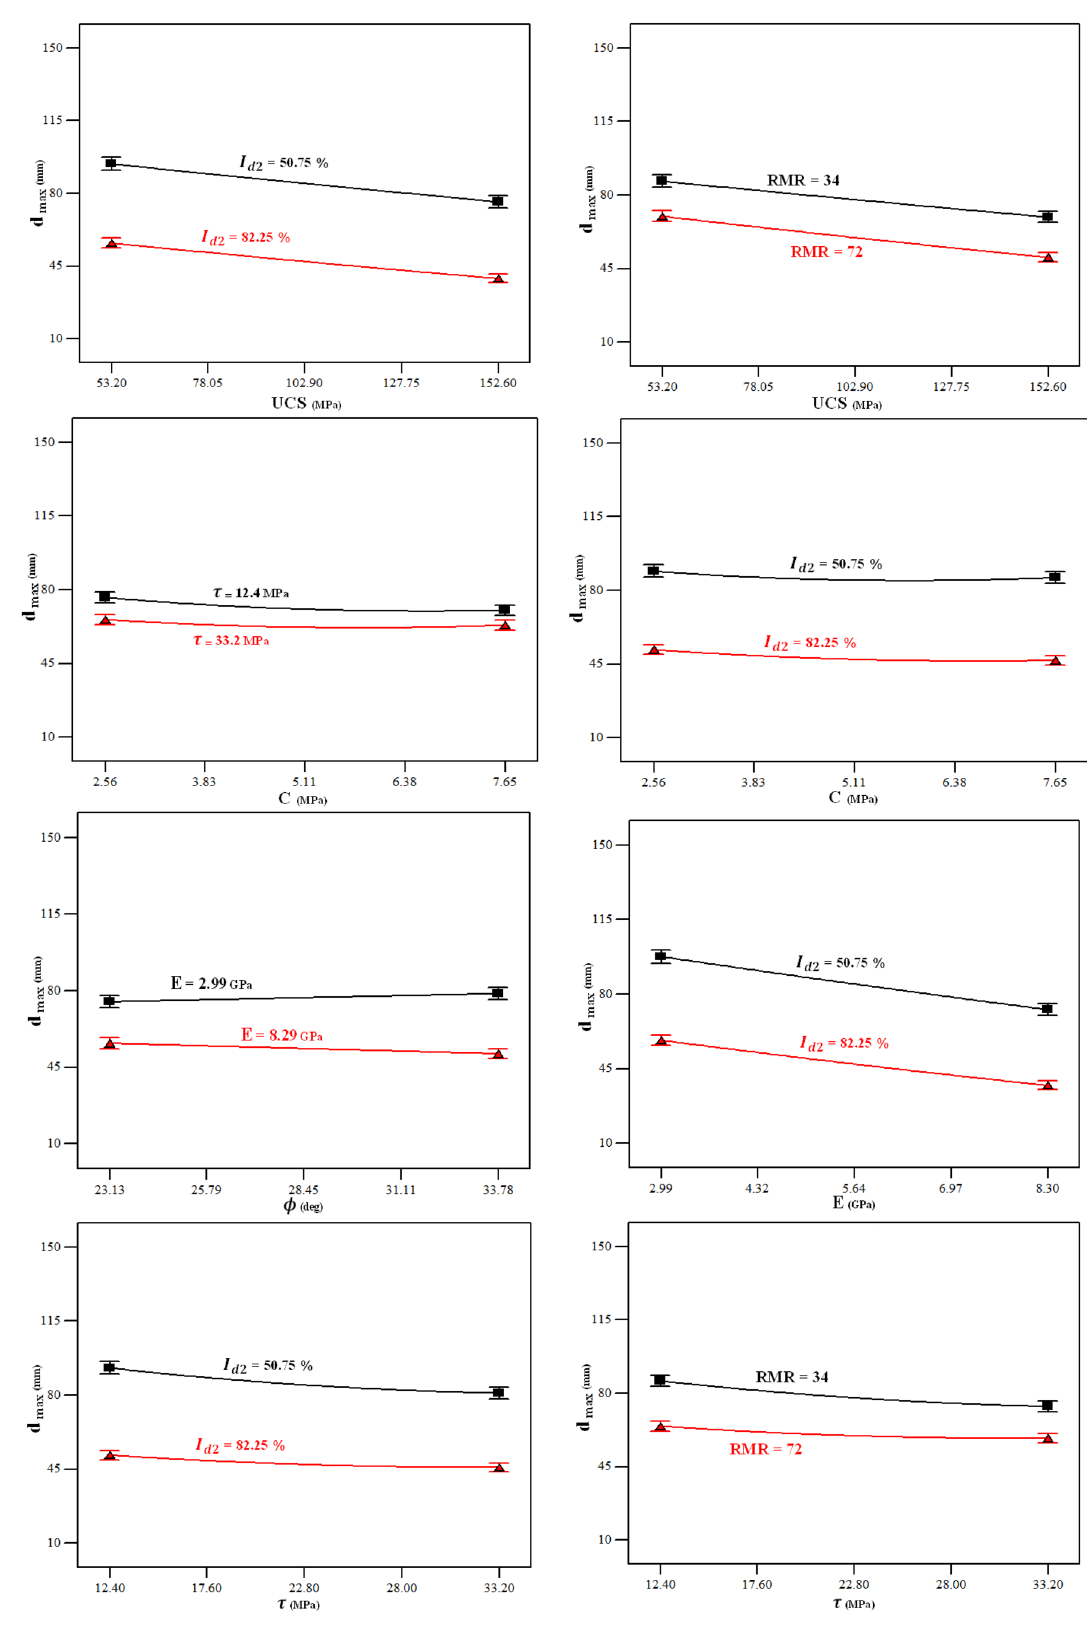
Figure 13. Pairwise interaction effects of input variables on the d max